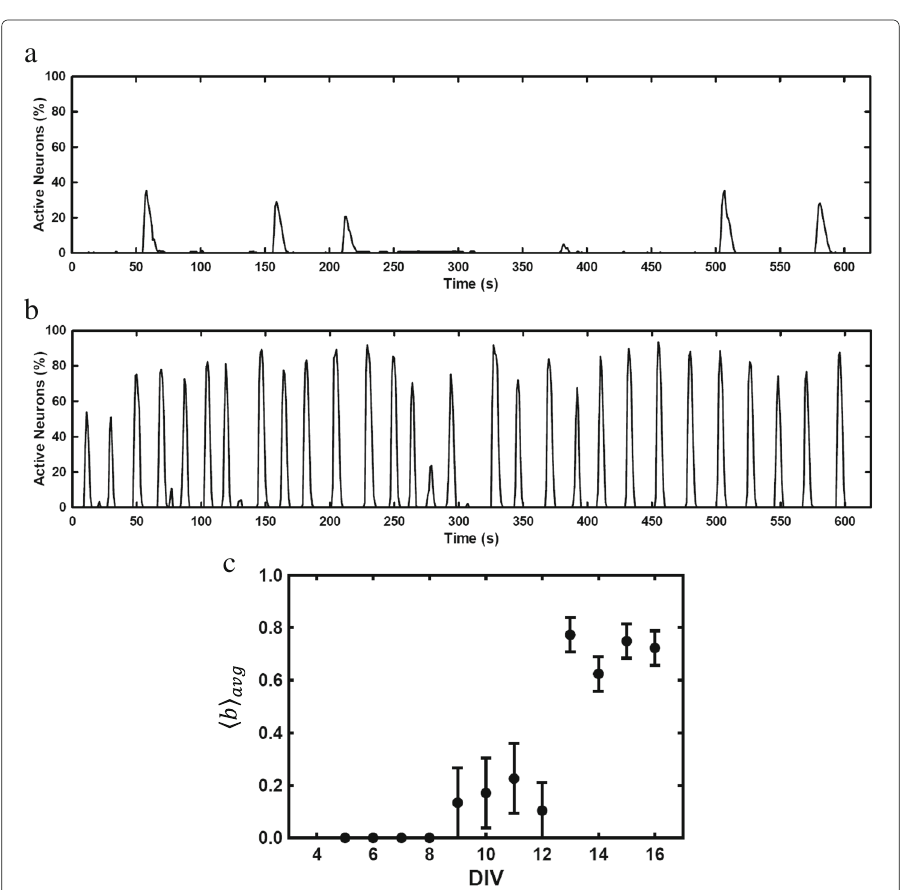
Fig. 2 Neuronal network bursting. Percentage of spontaneously active neurons in mapped neuronal networks at a DIV 9 and b DIV 16. A neuron was considered active when it exhibited > 1% Ca responses ( (cid:2) F / F ). A network bursting event was defined to occur when ≥ 20% of mapped neurons were active within the same 1-sec time frame. The bursting parameter, b , characterized the fraction of the time a neuron participated in a network bursting event. c (cid:4) b (cid:5) avg , which is the average of b over all mapped neurons and over all networks for that day, shows network bursting as a function of network age